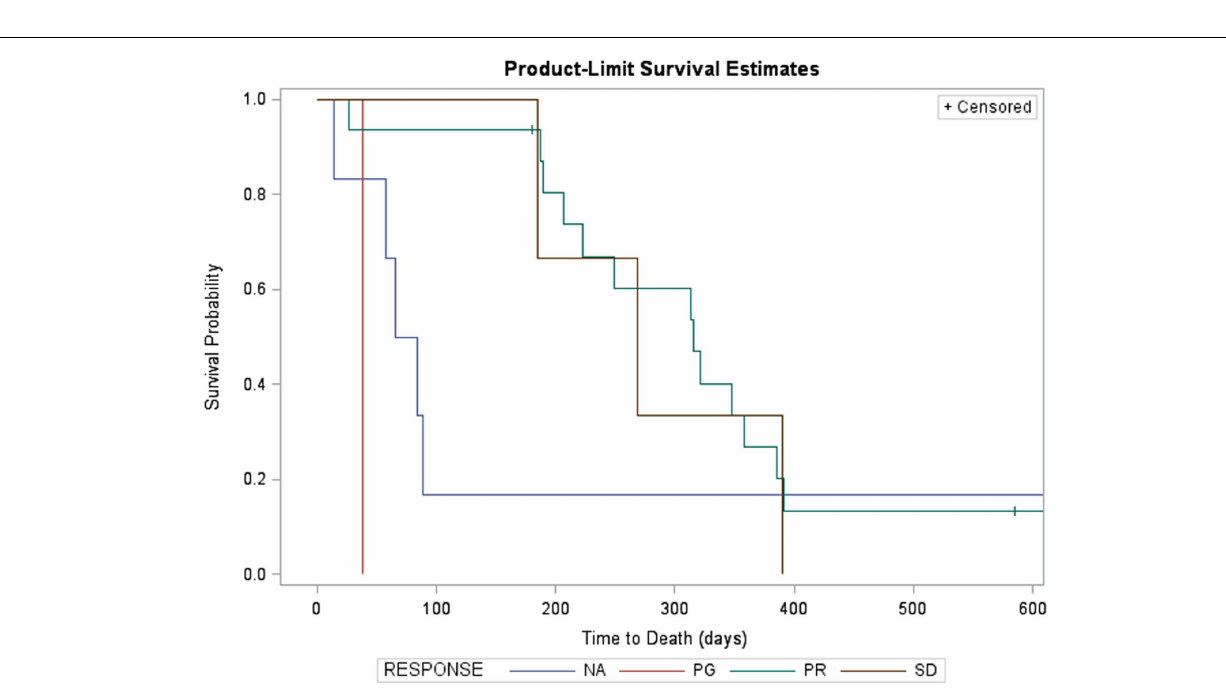
FIGURE 2 | Kaplan–Meier survival estimates of subjects who showed partial response (green, n = 12, two censored), progressive disease (red, n = 1), and those not evaluable for response due to early death (blue, n = 5) .Three subjects with stable disease are not shown due to missing